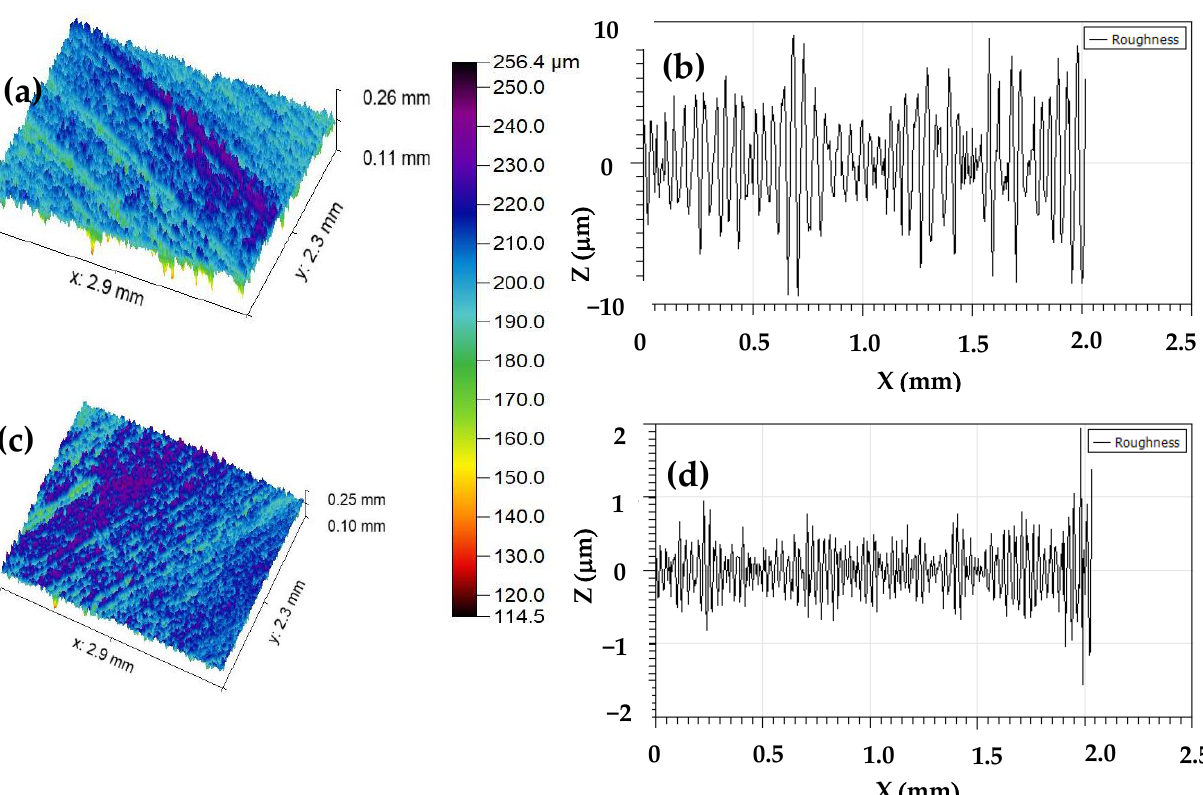
Figure 10. Worn out 3D topographies and their corresponding 2D roughness profiles: ( a , b ) CACF specimen and ( c , d ) SLM specimen.